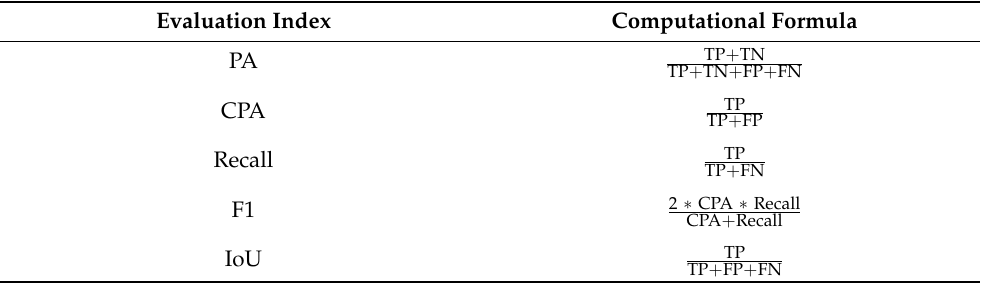
Table 2. Calculation formula of evaluation